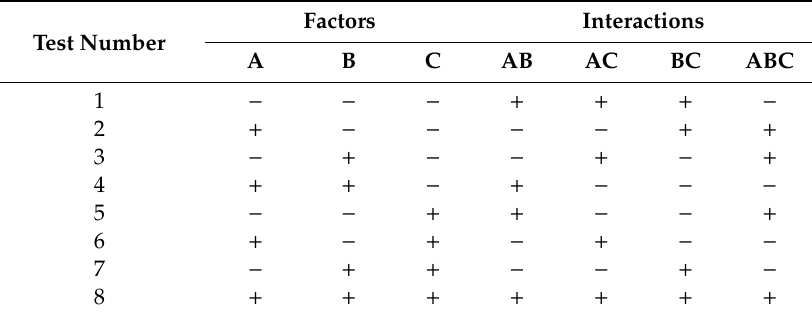
Table 3. Design matrix and signs for seven e ff ects in the 2 3 full factorial